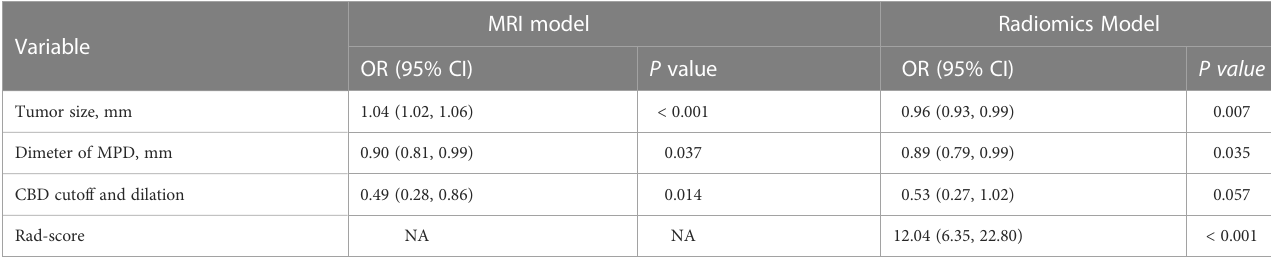
TABLE 3 Multivariable logistic regression model distinguishing PASC from PDAC.